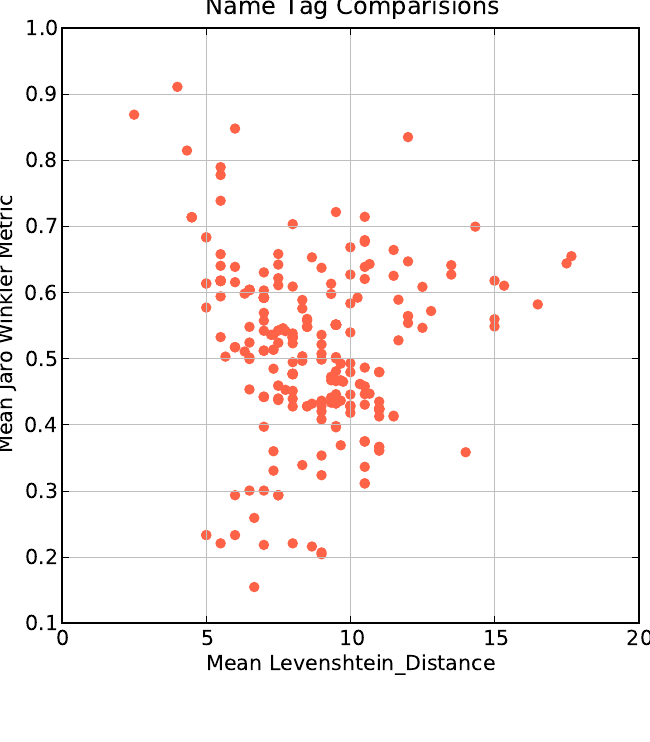
Figure 3. Using the Levenshtein distance and JaroWinkler distance metrics to visualize changes to “name” attribute tags of 412 objects in our OSM case-study